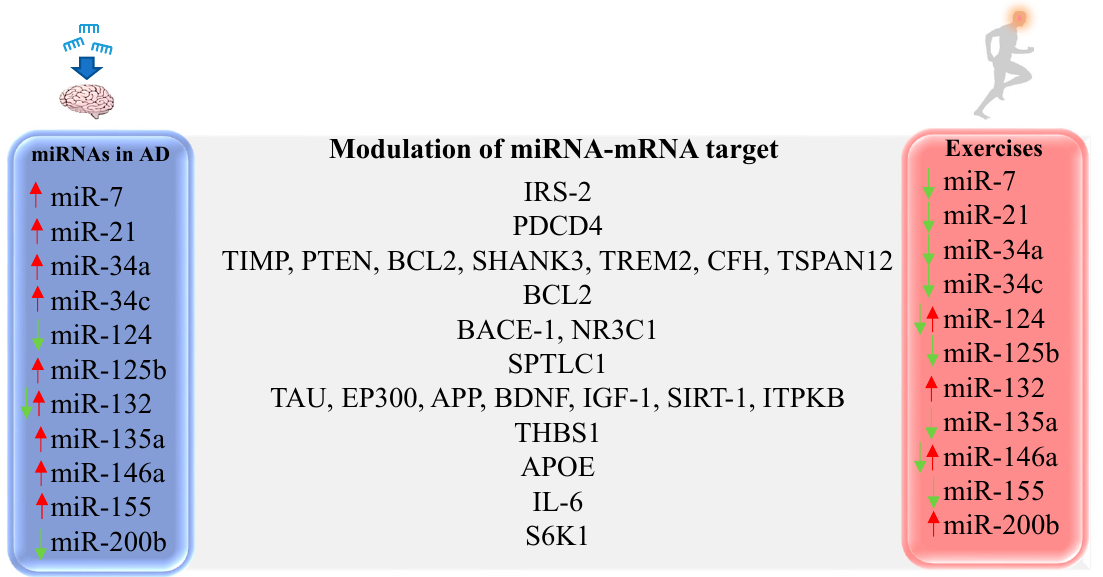
Figure 2. Representative miRNAs with altered expression in AD and di ff erentially expressed